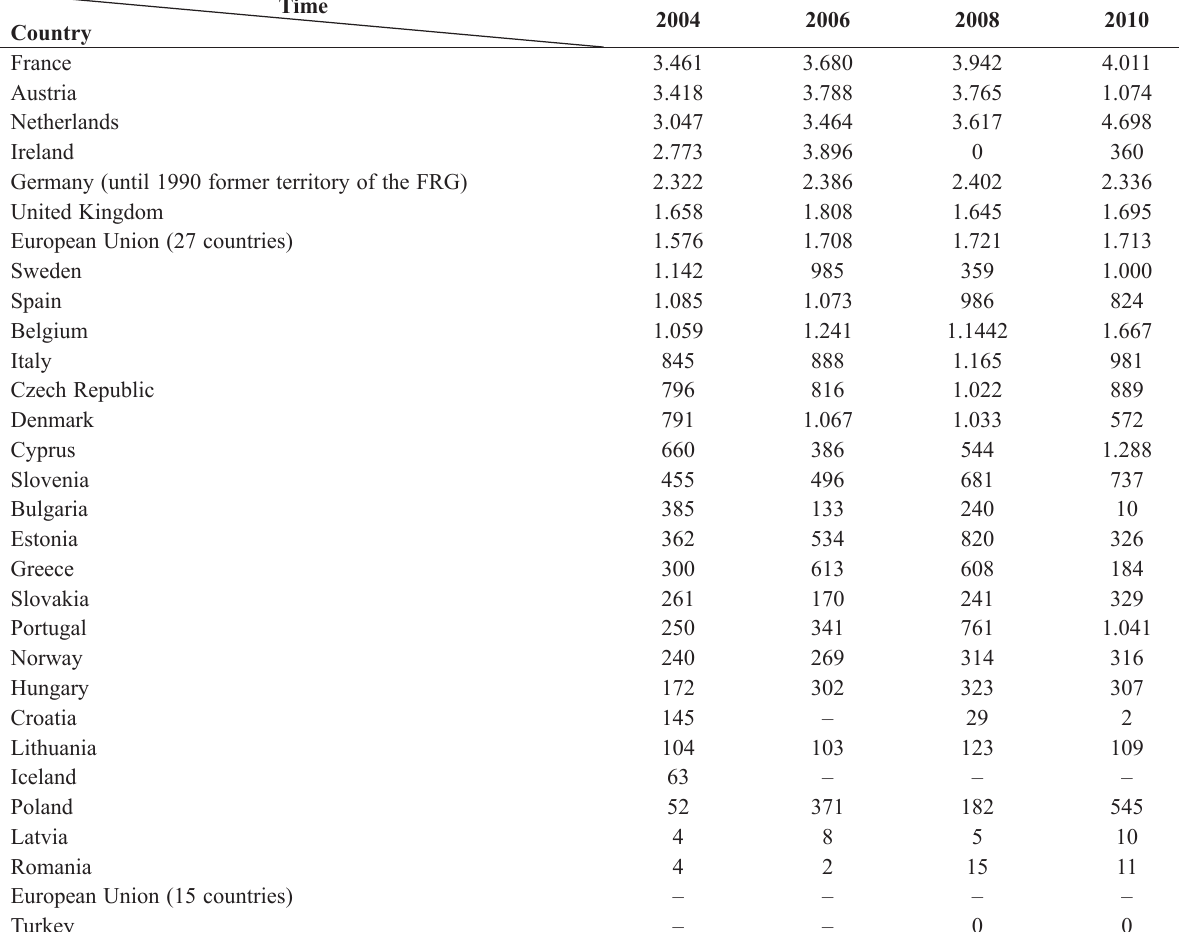
Table 1. C&DW generation in the European countries during 2004–2010 (Eurostat